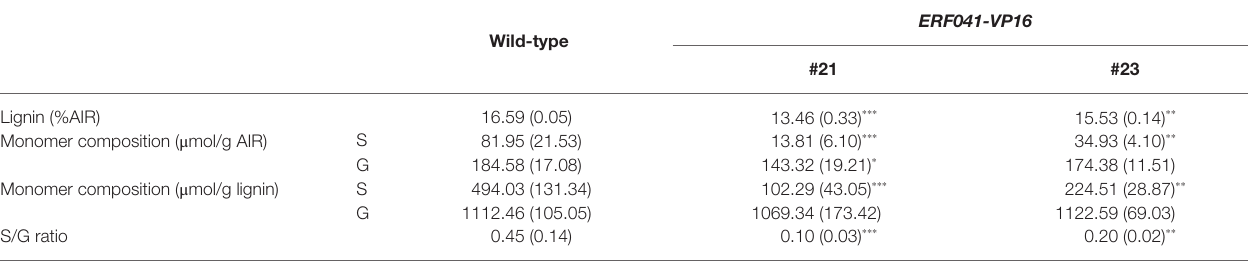
TABLE 1 | Lignin content and S/G ratio of the inflorescence stems.